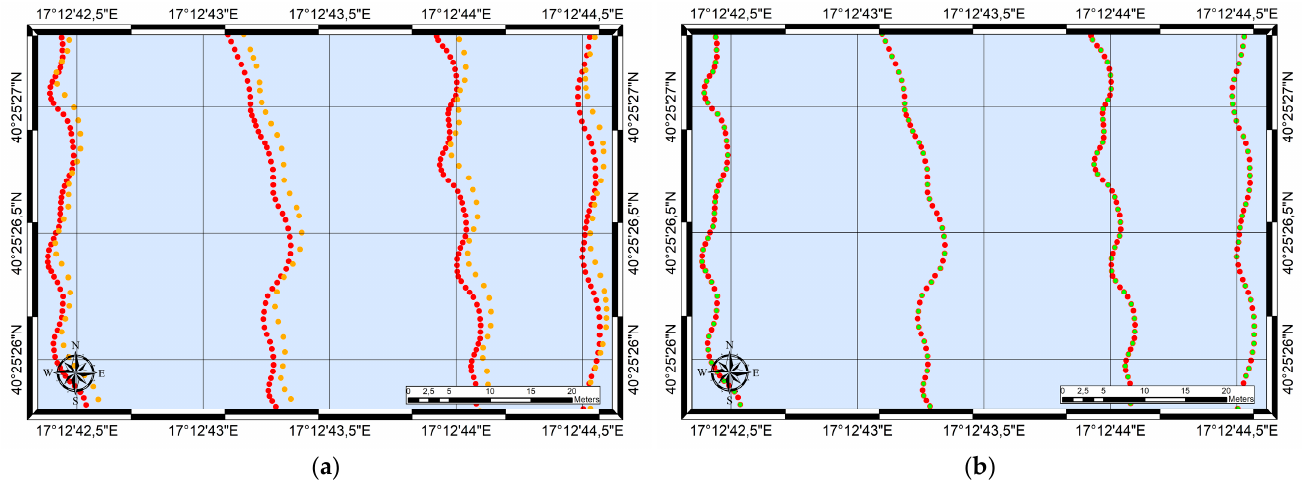
Figure 5. ( a ) Comparison between File Sonar + SPP (in orange) and File PPK (in red); ( b ) comparison between Sonar + SPP + PPK (in green) and File PPK (in red).